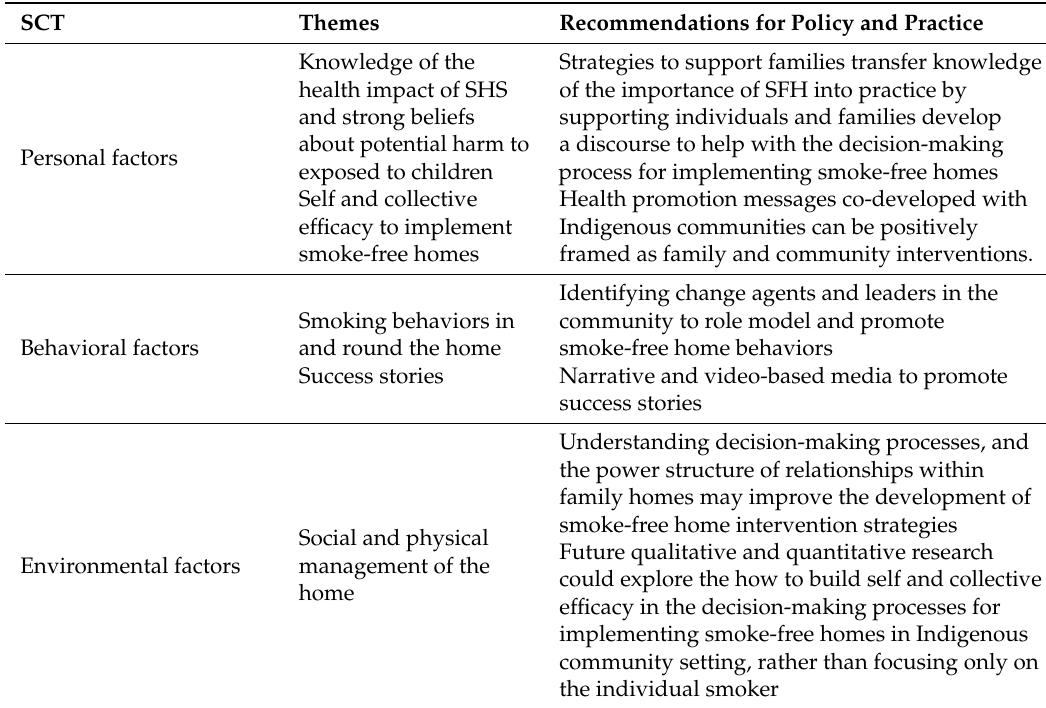
Table 2. Recommended policy, practice and research